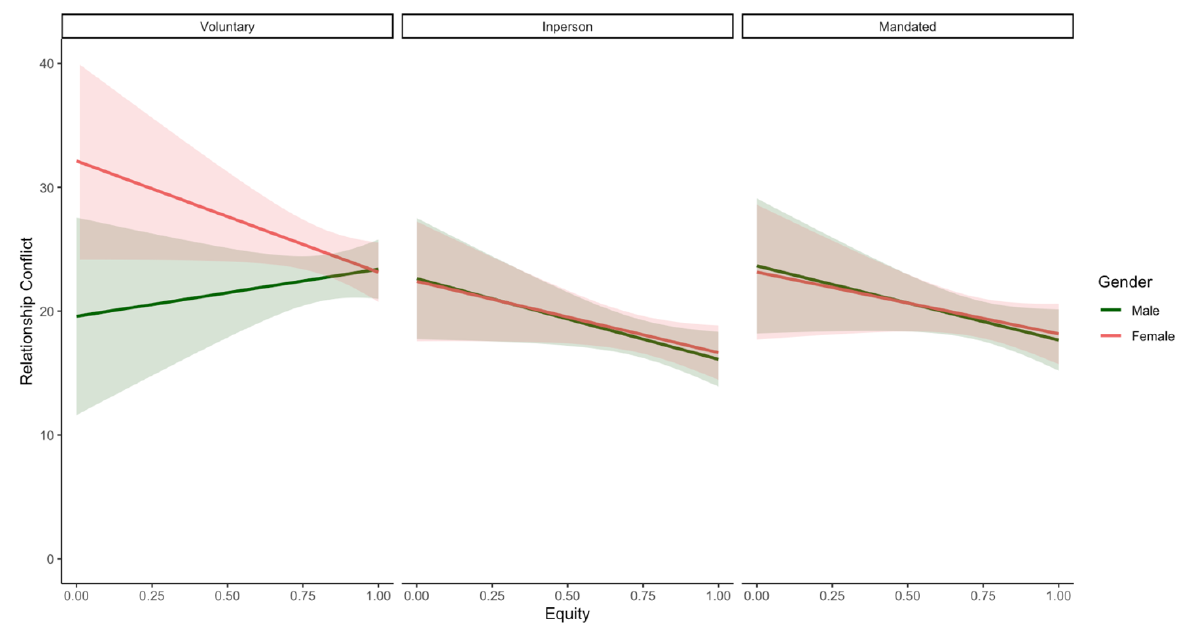
Figure 7. Simple slopes analyses demonstrating the three-way interaction between equity, gender, and schooling status on parents’ relationship conflict in mixed -gender couples.